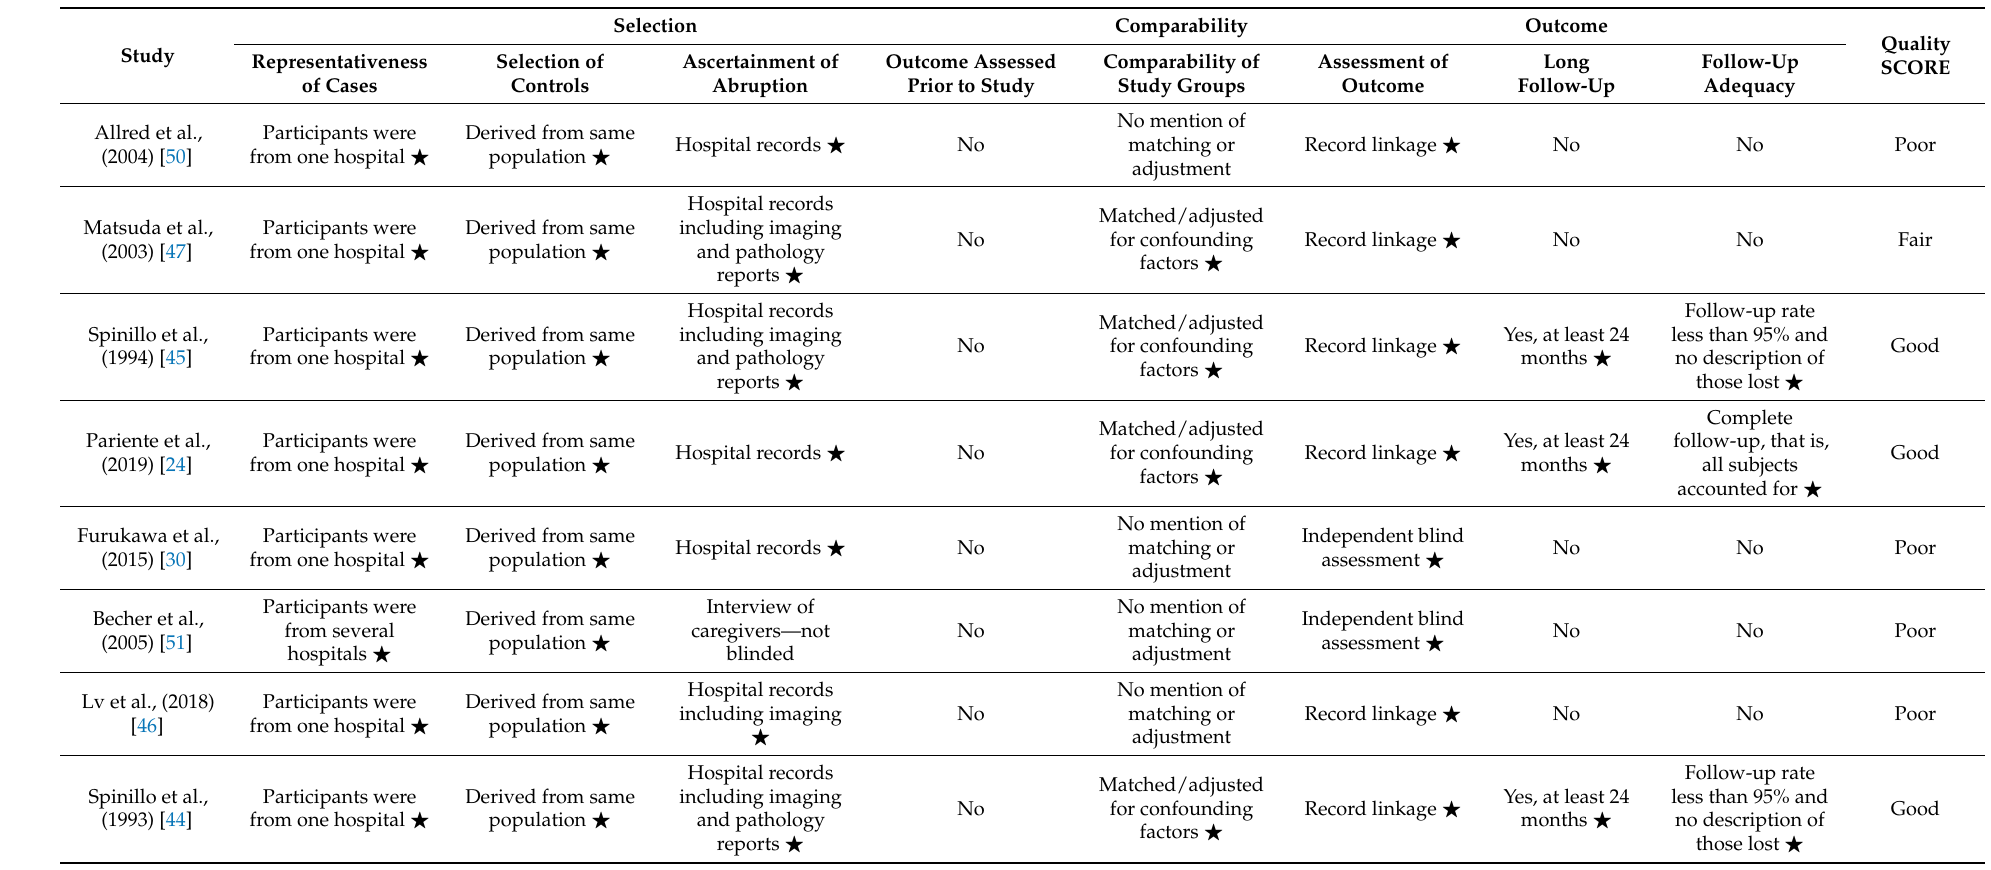
Table 4. Assessment of study quality using the Ottawa–Newcastle scale. (cid:70) Star denotes that the specific criteria are